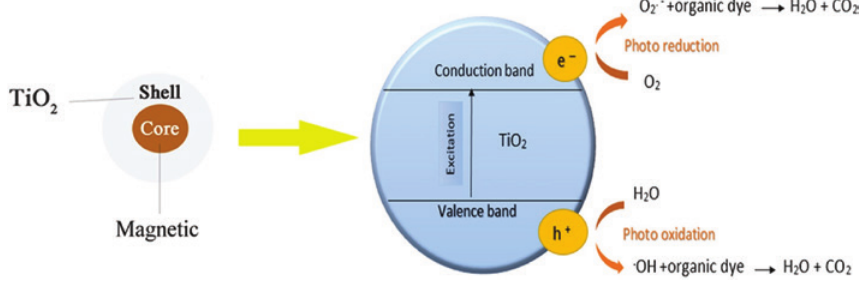
Figure 18: The photocatalyst mechanism in the degradation of toxic